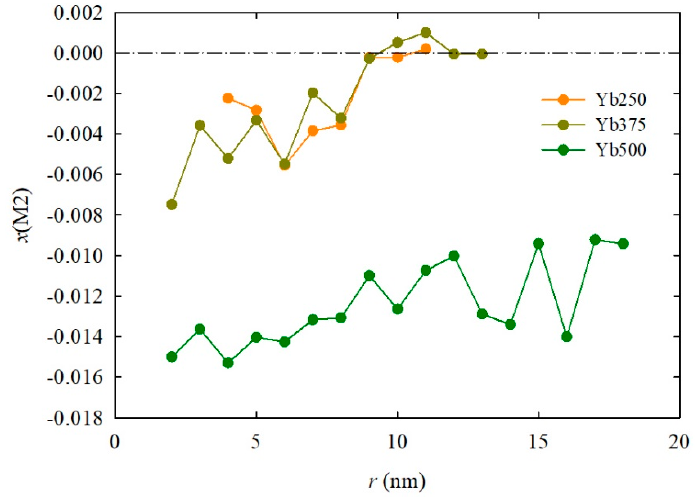
Figure 7. x (M2) from box-car refinements performed on X-ray PDF.